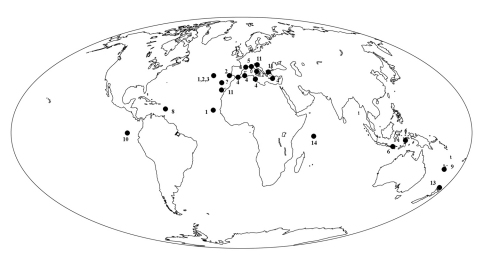
Distribution of species of the genus Calthropella. Black dots indicate approximate localities from which species were reported. 1 = Calthropella (Calthropella) simplex 2 = Calthropella (Calthropella) geodioides 3 = Calthropella (Calthropella) durissima 4 = Calthropella (Calthropella) pathologica 5 = Calthropella (Calthropella) inopinata 6 = Calthropella (Calthropella) xavierae sp. n. 7 = Calthropella (Calthropella) spec. Ambon 8 = Calthropella (Pachataxa) lithistina 9 = Calthropella (Pachataxa) enigmatica 10 = Calthropella (Pachataxa) pyrifera sp. n. 11 = Calthropella (Corticellopsis) stelligera 12 = Calthropella (Corticellopsis) recondita 13 = Calthropella (Corticellopsis) novaezealandiae 14 = Calthropella (Corticellopsis) spec. Seychelles. Question mark indicates position of an unspecified record of Calthropella sample.